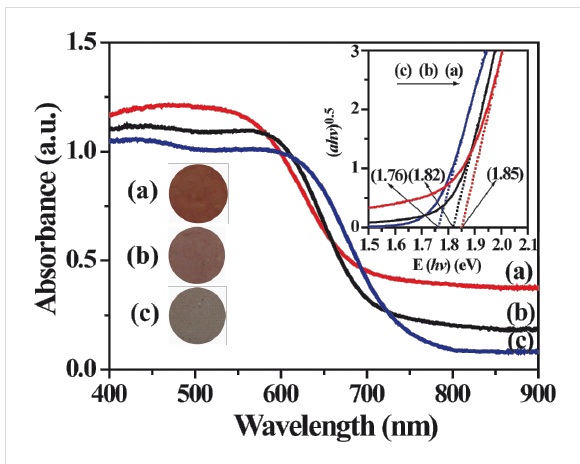
Figure 5: UV–visible diffuse reflectance spectra, the calculated band gaps (upper right inset) and the corresponding colours (lower left inset) of Ag 2 CrO 4 samples prepared by different methods: (a) micro- emulsion, (b) precipitation, and (c) hydrothermal.